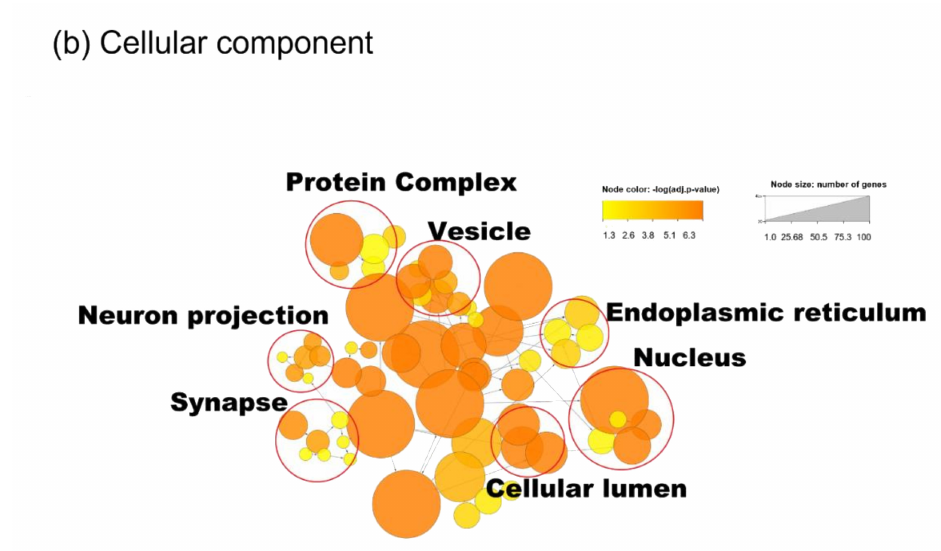
Figure 9. ( a ) GO annotations for biological process of the miRNA target of preferentially EV secreted miRNAs (from Figure 7) and ( b ) GO annotation for the cellular component of the miRNA target of the preferentially EV secreted miRNAs (from Figure 7). The analysis was performed using the BINGO app in Cytoscape_v3.9.1, with the adjusted p -value < 0.03 and the number of genes above